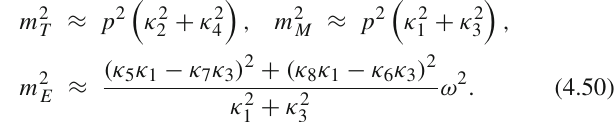
Fig. 7 Tree-leveldiagramsgeneratingtheentriesof M 6 × 6 blockofthe neutrino mass matrix (see Eq. (4.54)). The flavour indices i , k denote the last six entries in (cid:8) N in Eq. (4.53). The Yukawa coupling G is equal to y A and y A (A = L , R , F). For more details, 23 , 24 , 27 , 28 23 , 24 , 27 , 28 see Appendix C2